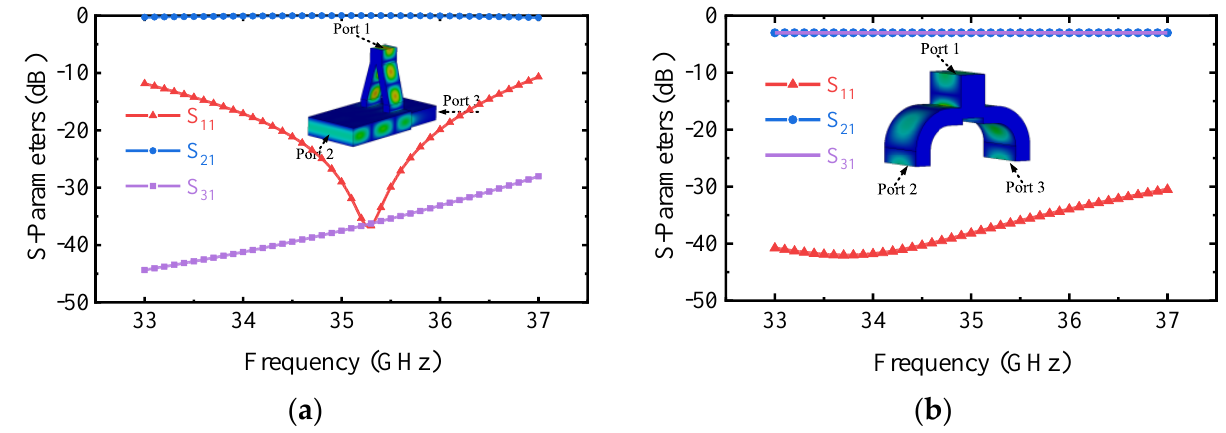
Figure 4. Simulated S-parameters of the ( a ) Small α mode converter. ( b ) Y-type power divider. After determining the position of the mode converter input port, a Y-type power di- vider is designed and simulated. As shown in Figure 4b, the S 21 is greater than − 0.45 dB, and the S − 30 dB between 33–37 GHz. The results indicate 11 is lower than that the performance of this component does not affect the overall performance of the mode